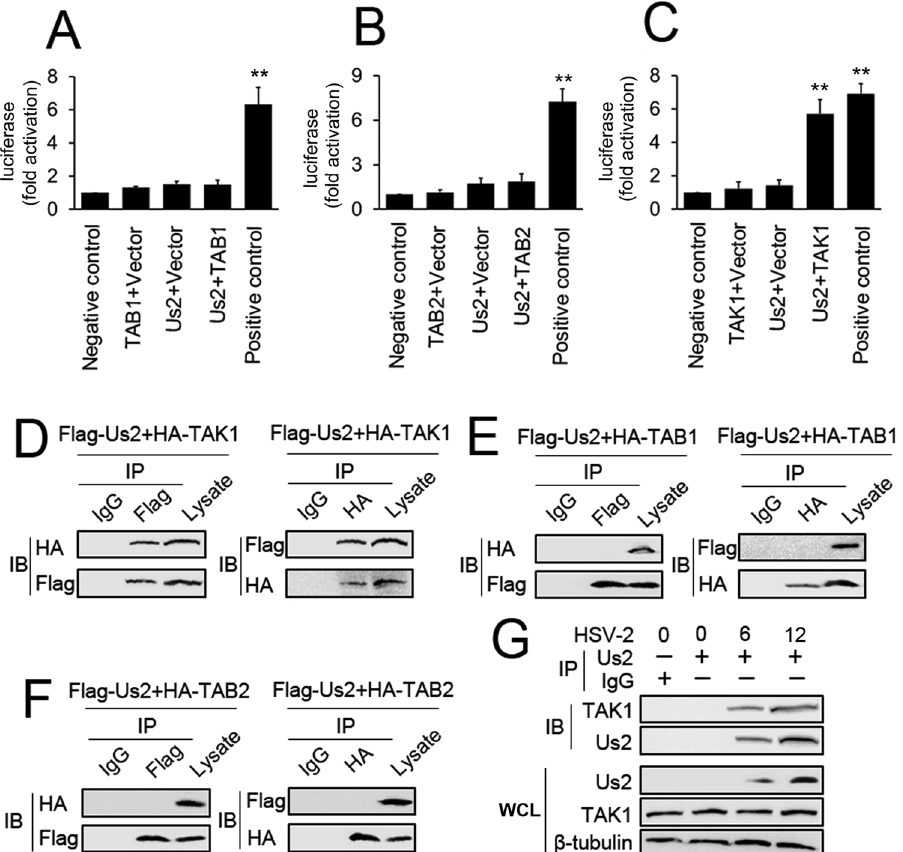
Figure 3. Detection of the interaction between Us2 and TAK1. (A) 293 T cells were co-transfected with pG5-luc (a luciferase reporter plasmid), pVP16-Us2, and pM-TAB1 or with control plasmids for 48 h prior to luciferase assays. ( B and C ) Experiments were performed as in A except that the 293 T cells were transfected with pM- TAB2 ( B ) or pM-TAK1 ( C ). ( D ) 293 T cells were transfected with Flag-tagged Us2 (Flag-Us2) and HA-tagged TAB1 (HA-TAB1). Forty-eight hours post-transfection, co-immunoprecipitation and immunoblot analysis were performed with the indicated antibodies. ( E and F ) Experiments were performed as in D except cells were transfected with HA-tagged TAB2 (HA-TAB2) ( E ) or HA-tagged TAK1 (HA-TAK1) ( F ). ( G ) End1/E6E7 cells were infected with HSV-2 for the indicated times or left uninfected. Immunoprecipitation and immunoblot analysis were performed with the indicated antibodies. All experiments were repeated at least three times with consistent results. Bar graphs represent the mean ± SD, n = 3 ( * P < 0.05, ** P <